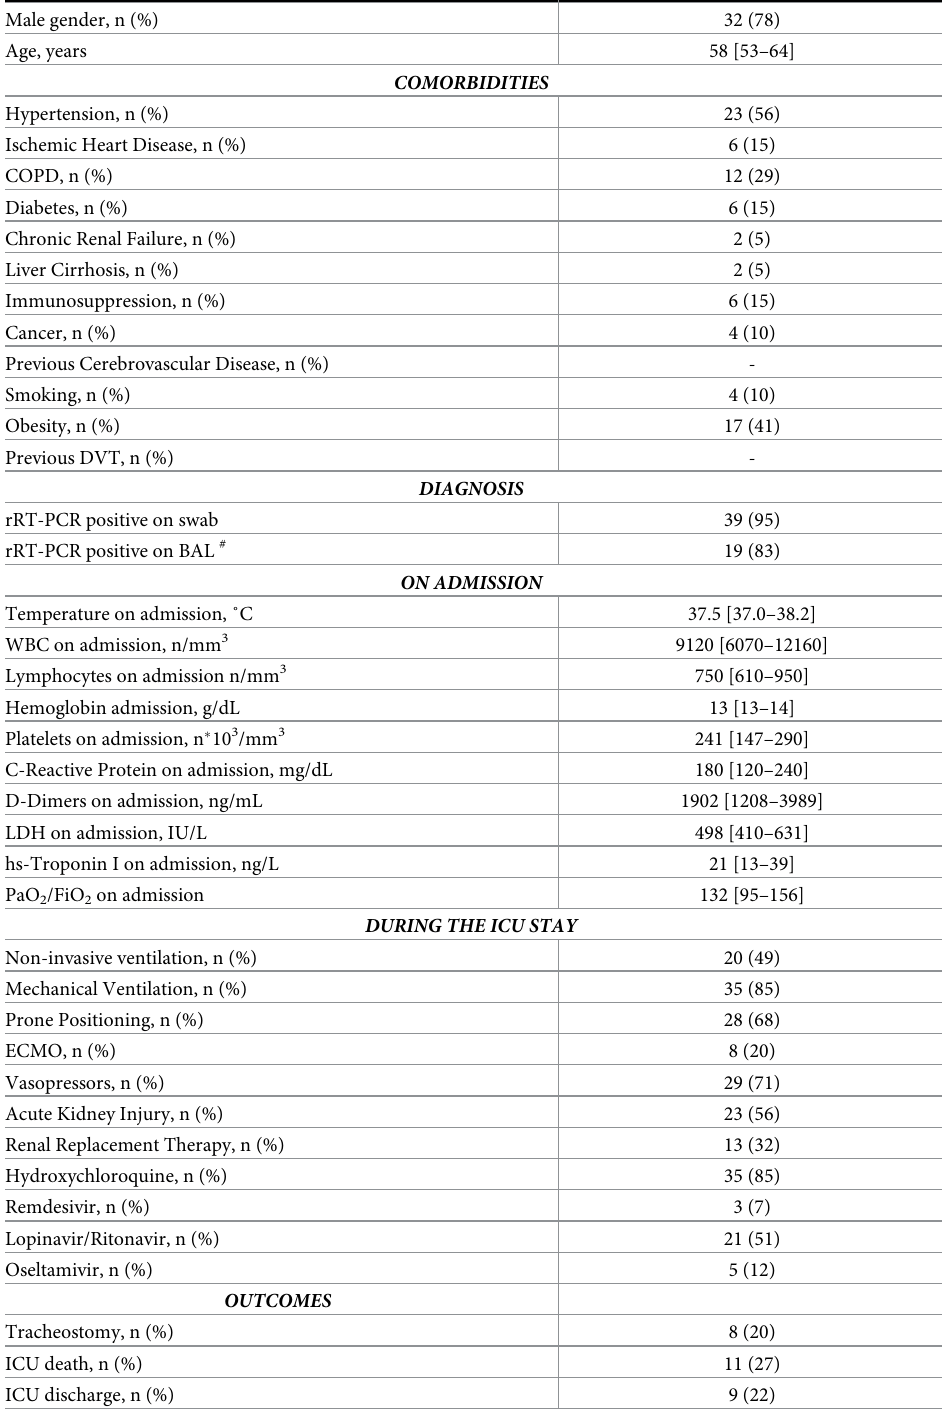
Table 1. Characteristics of the study population. Data are presented as median [IQRs] or count